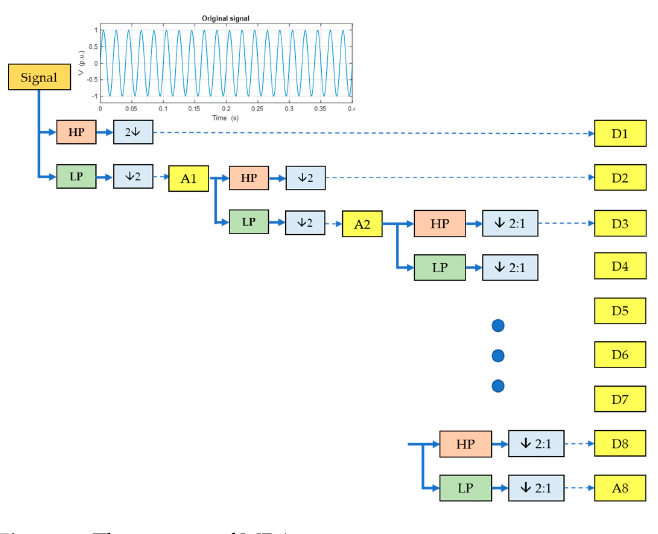
Figure 2. The process of MRA.